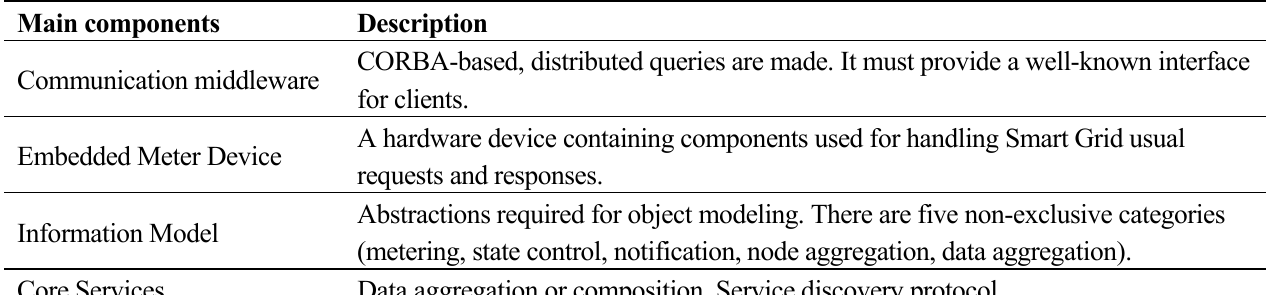
Table 8. Description of CoSGrid main